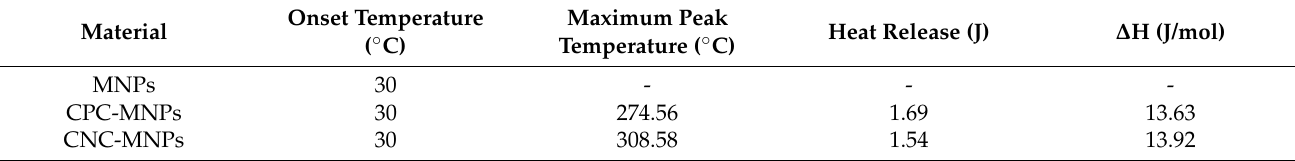
Table 2. Heat released and ∆ H of MNPs and the